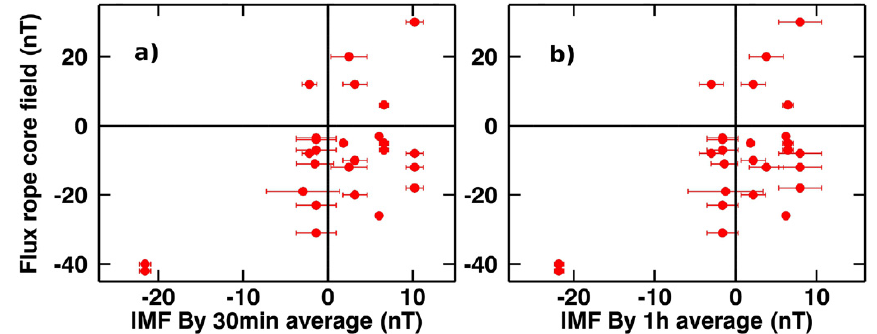
Fig. 7. X-axis: The IMF B y averaged over the last (a) 30min and (b) 60min before each Cluster X-line encounter. Y-axis: The maximum core field for each flux rope. The error bars represent the IMF B y standard deviation. The error in identifying the maximum core field is estimated to be about 1nT.